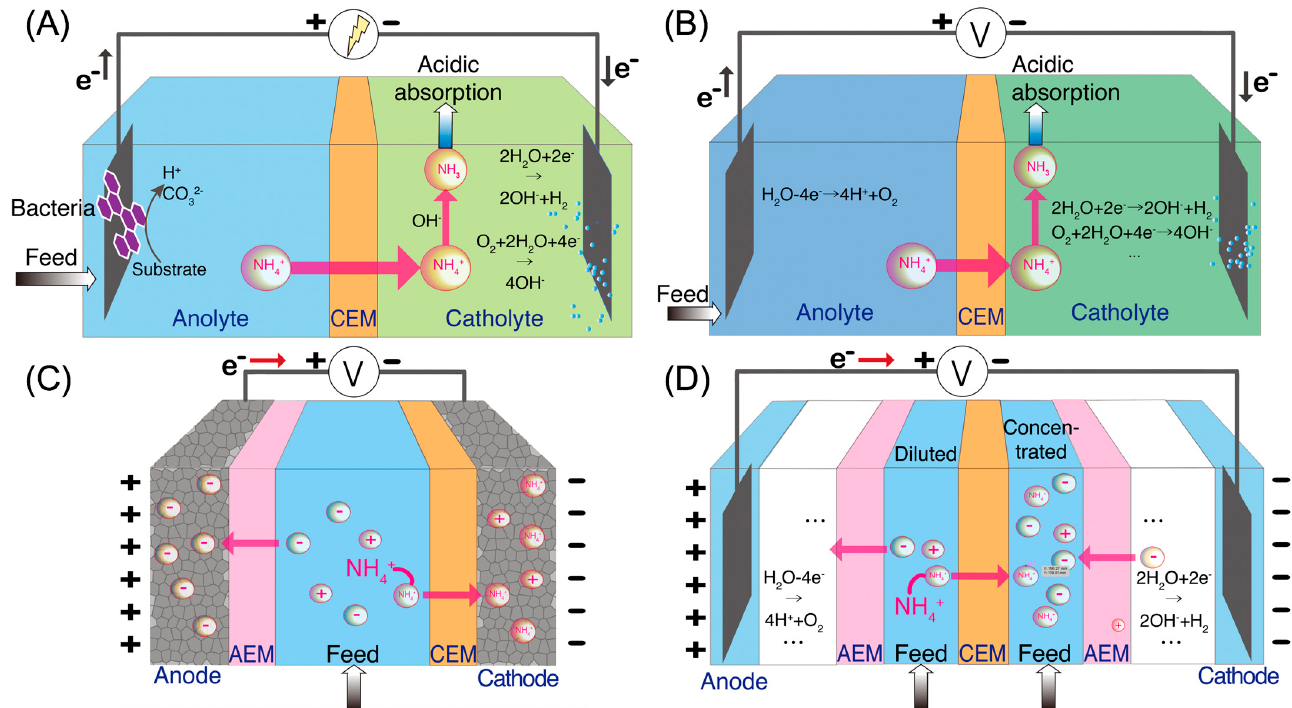
Figure 1. Schematic of four types of ammonia recovery technologies: ( A ) bioelectrocehmical system (BES), ( B ) electrochemical stripping (ECS), ( C ) membrane electrosorption (MES), and ( D ) electrodialysis (ED).